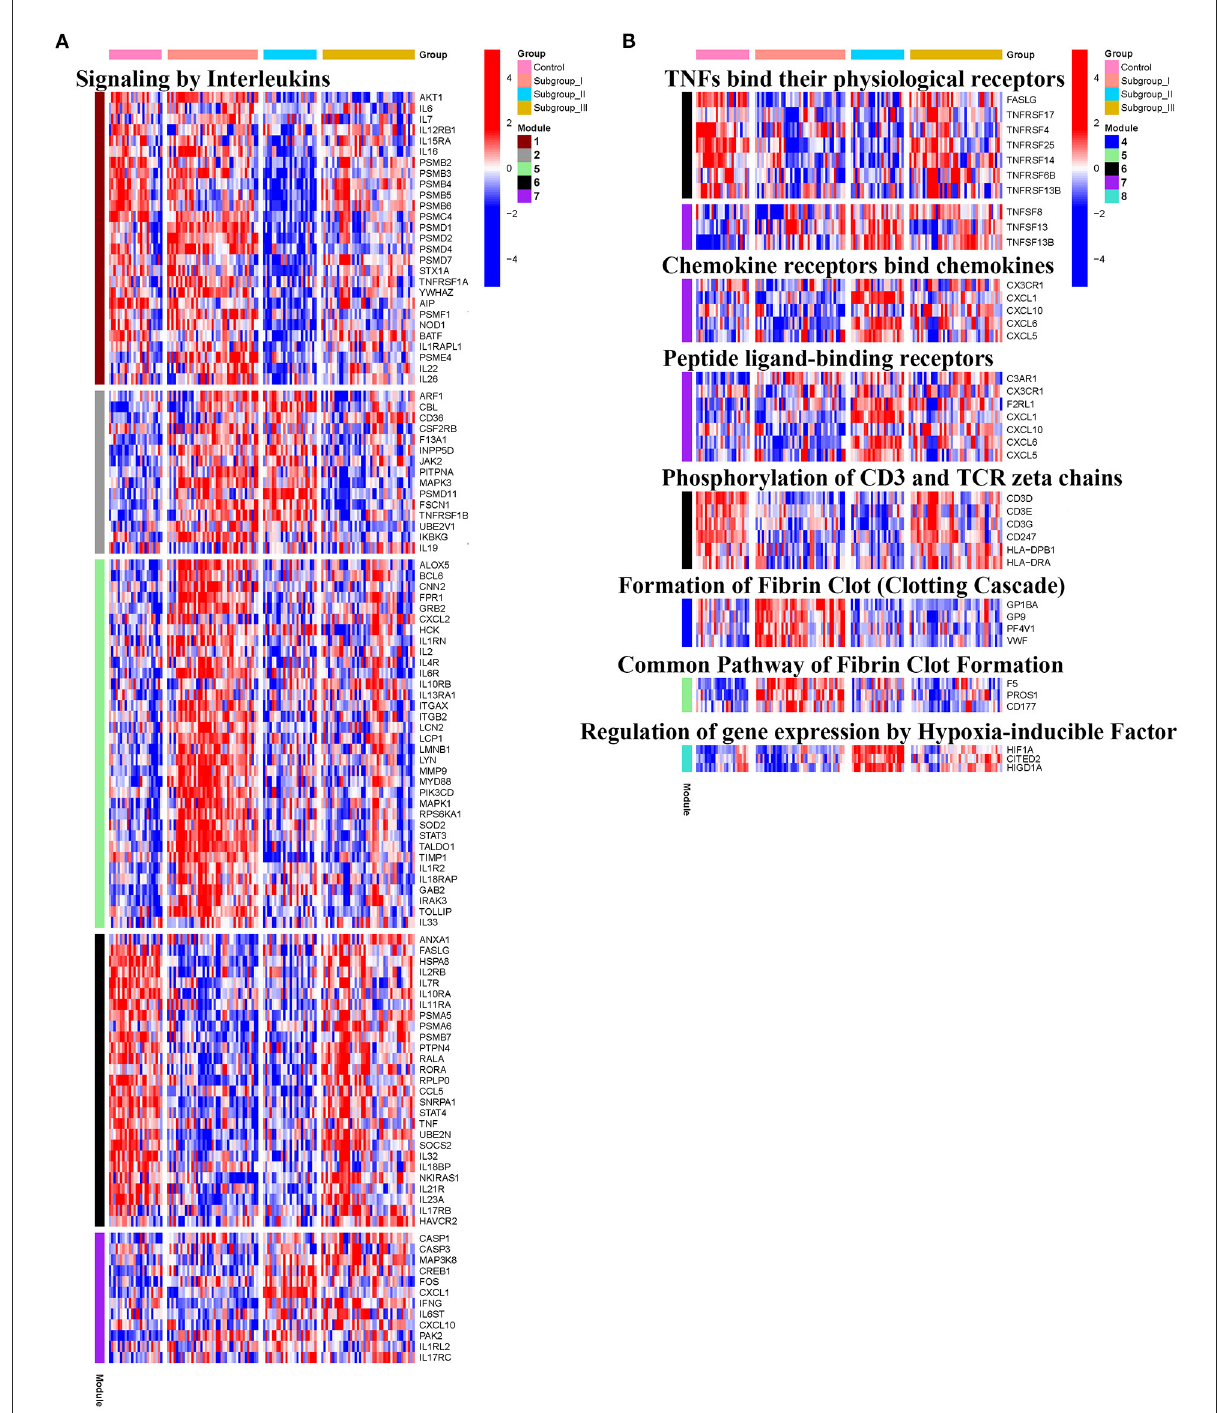
FIGURE10 Heatmap showing the expression level of genes in representative subgroup-specific Reactome pathways related to inflammation as indicated in Signaling by Interleukins (A) and TNFs bind their physiological receptors, Chemokine receptors bind chemokines, Peptide ligand-binding receptors, Phosphorylation of CD3 and TCR zeta chains, Formation of Fibrin Clot Formation, and Relation of gene expression by Hypoxia-inducible Factor (B) and corresponding signature of each co-expression module among subgroups, heatmap colors correspond to the level of mRNA expression as indicated in the color